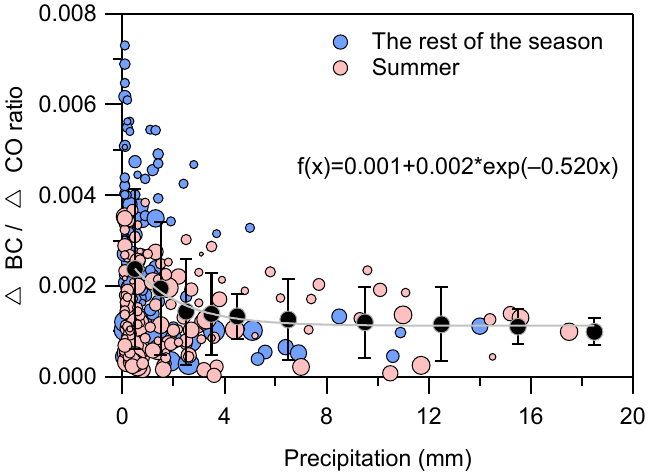
Figure 7. The △ BC/ △ CO ratio as a function of precipitation. The solid black circles present the average values (mean ± standard deviation) of the △ BC/ △ CO ratio in different precipitation bins for the entire period. The curve fitting was performed with these averaged data points. The size-scale data points refer to surface wind speed.